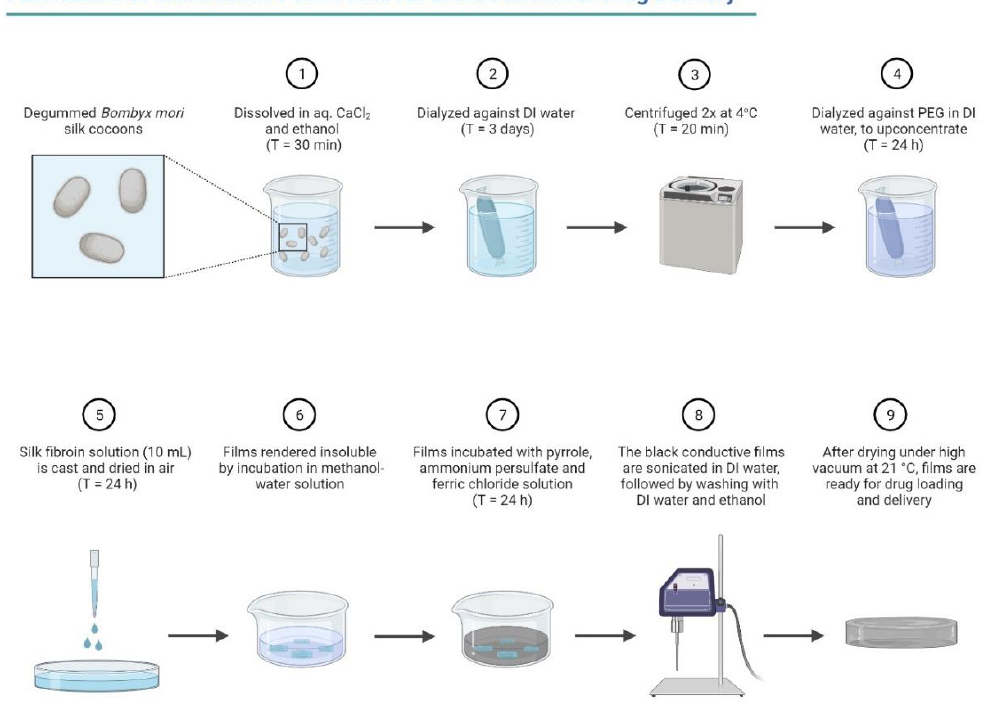
Figure 2. Fabrication of electroactive silk forms for electrochemical drug delivery (generated by Bi- orender).